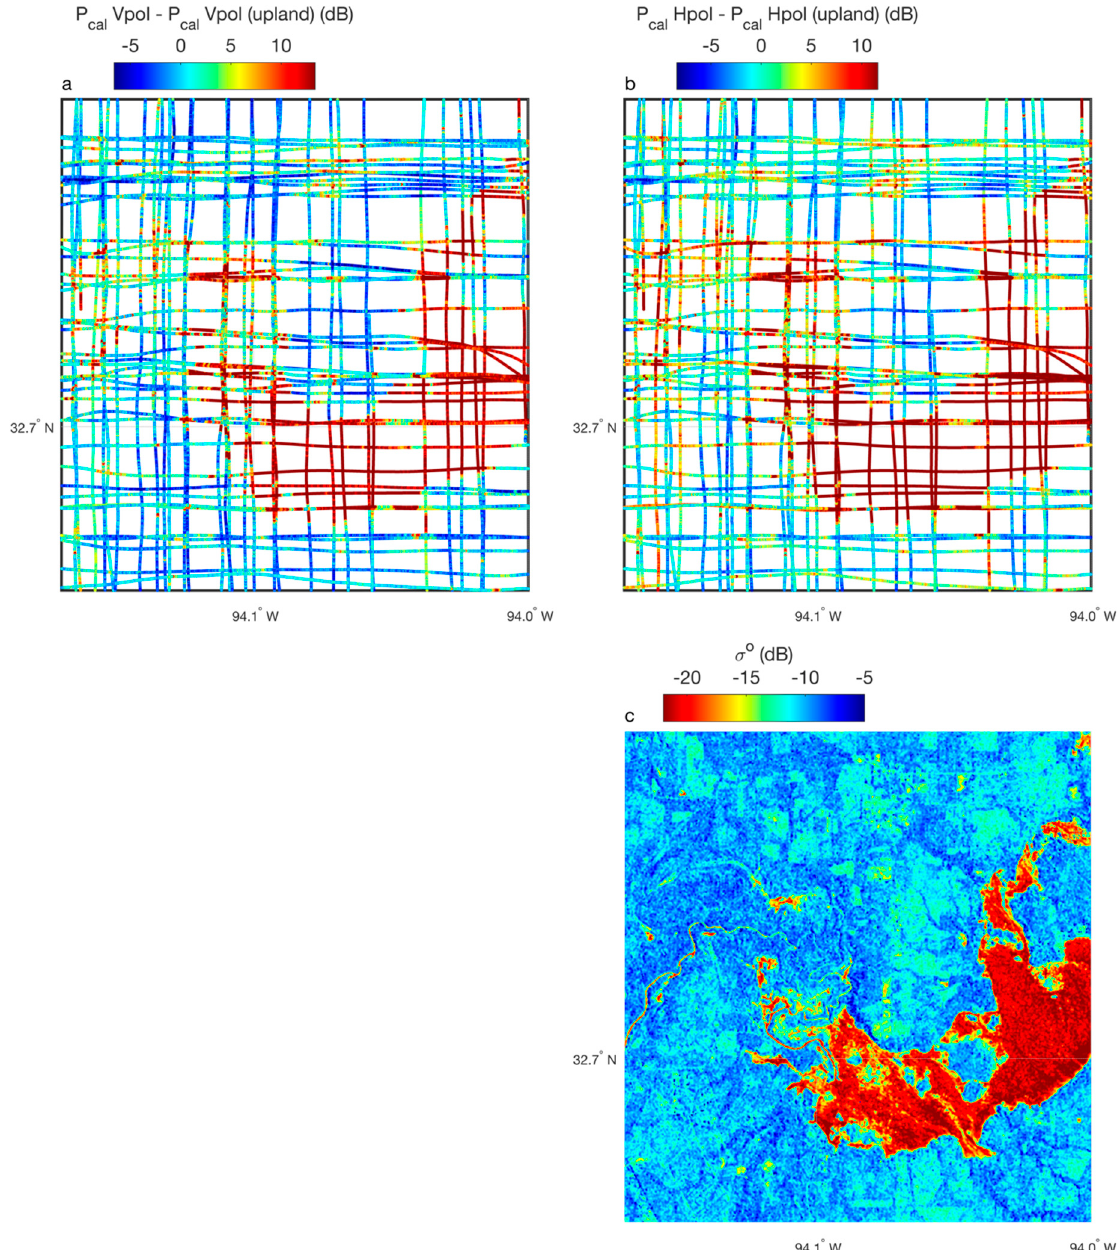
Figure 7. ( a ) Global Navigation Satellite System-Reflectometry (GNSS-R) Equation (8)’s P cal Vpol observations over Caddo Lake, acquired on 2 May 2017. Observations are relative to their mean value over uplands (156.63 dB). ( b ) Same as (a), except showing GNSS-R P cal Hpol observations, relative to their mean value over uplands (158.39 dB). ( c ) Sigma nought observations (VV pol) from Sentinel-1, acquired on 8 May 2017.